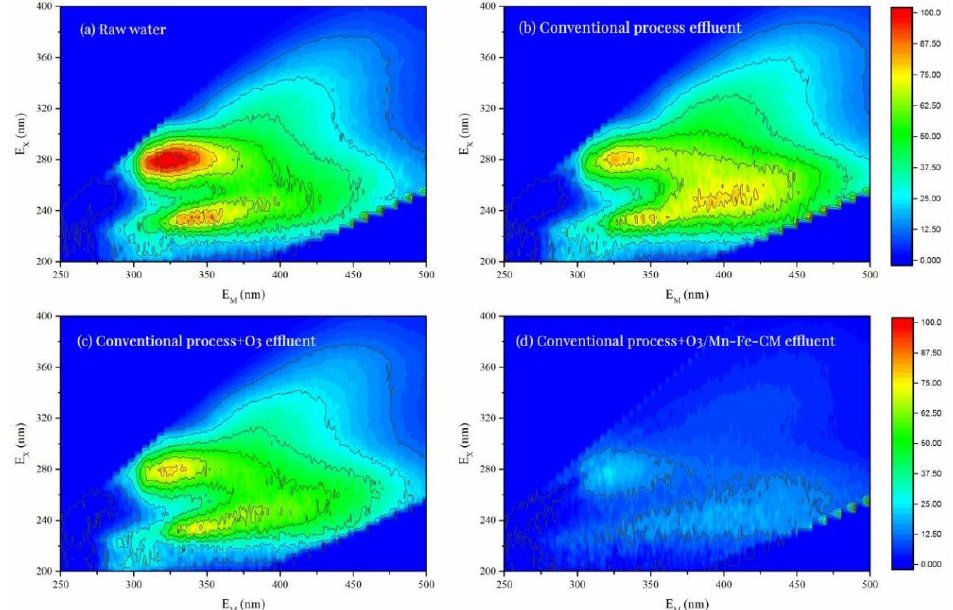
Figure 3. EEM characteristics of effluent along the route, ( a ) the raw water, ( b ) the conventional process effluent, ( c ) the conventional process+O 3 effluent, ( d ) the conventional process+O 3 /Mn-Fe- CM effluent